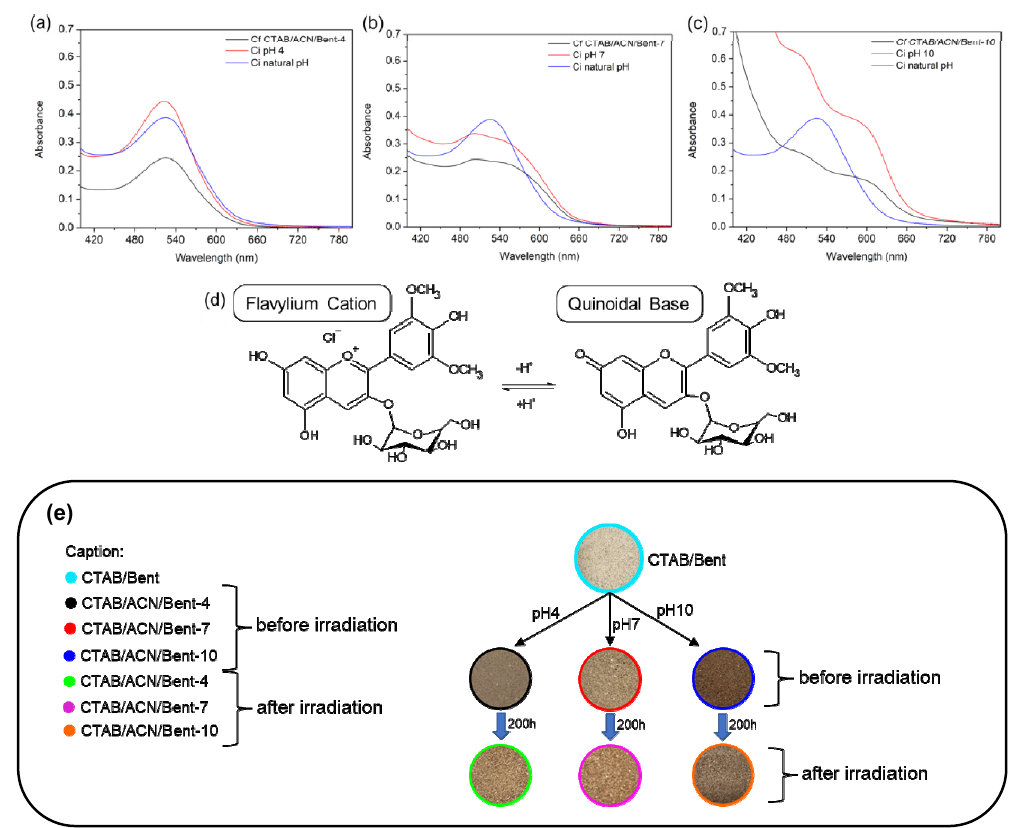
Figure 5. UV-Vis spectra of the ACN solutions at natural pH and pH 4 ( a ), 7 ( b ), and 10 ( c ) before and after incorporating dye in the CTAB/Bent hybrid. Ci and Cf are the initial and final dye concentrations, respectively, ( d ) deprotonation of the flavylium cations into the quinoidal base form of ACN ( e ) Digital photographs of the hybrid pigments before and after irradiation.